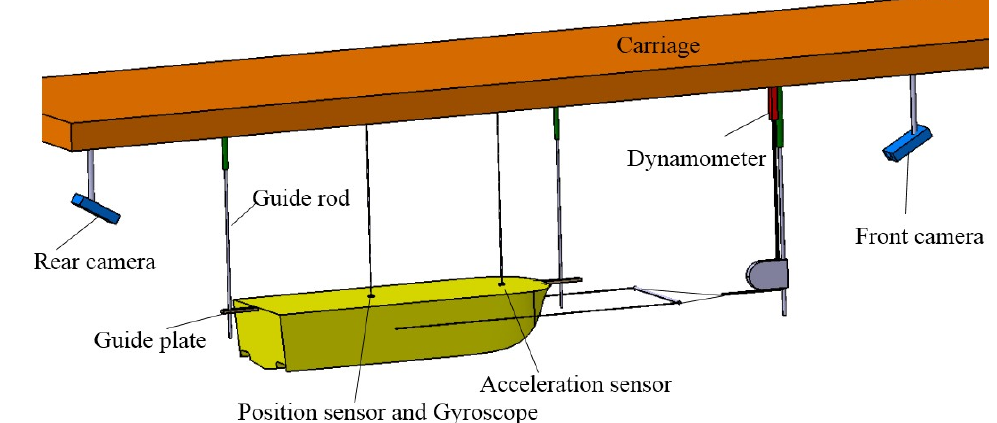
Figure 2. Sketch of the experimental set-up.